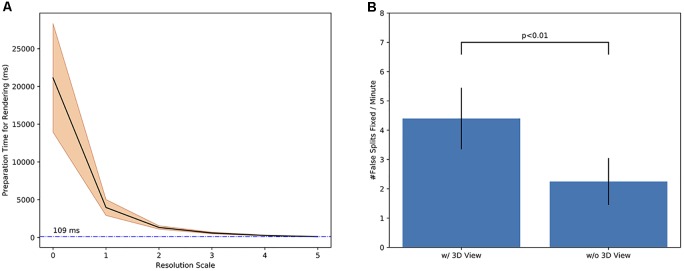
Experimental results showed that particular designs and strategies in NeuTu could help improve user experience and proofreading efficiency: (A) the waiting time for converting a body in DVID to geometric primitives for 3D rendering decreases exponentially as the downsampling scale increases, leading to real-time response (109 ± 66 ms) at scale 5 (downsampled by 32 along each dimension); (B) using 3D visualization can accelerate proofreading significantly, such as doubling the productivity in fixing false splits.